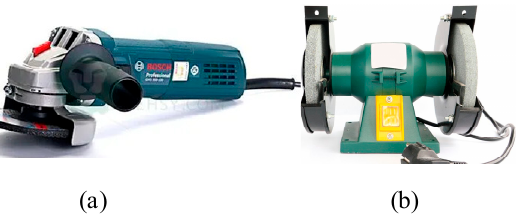
Figure 6. Electric grinding equipment. ( a ) Angled polishing machine. ( b ) Table-top grinding wheel machine.